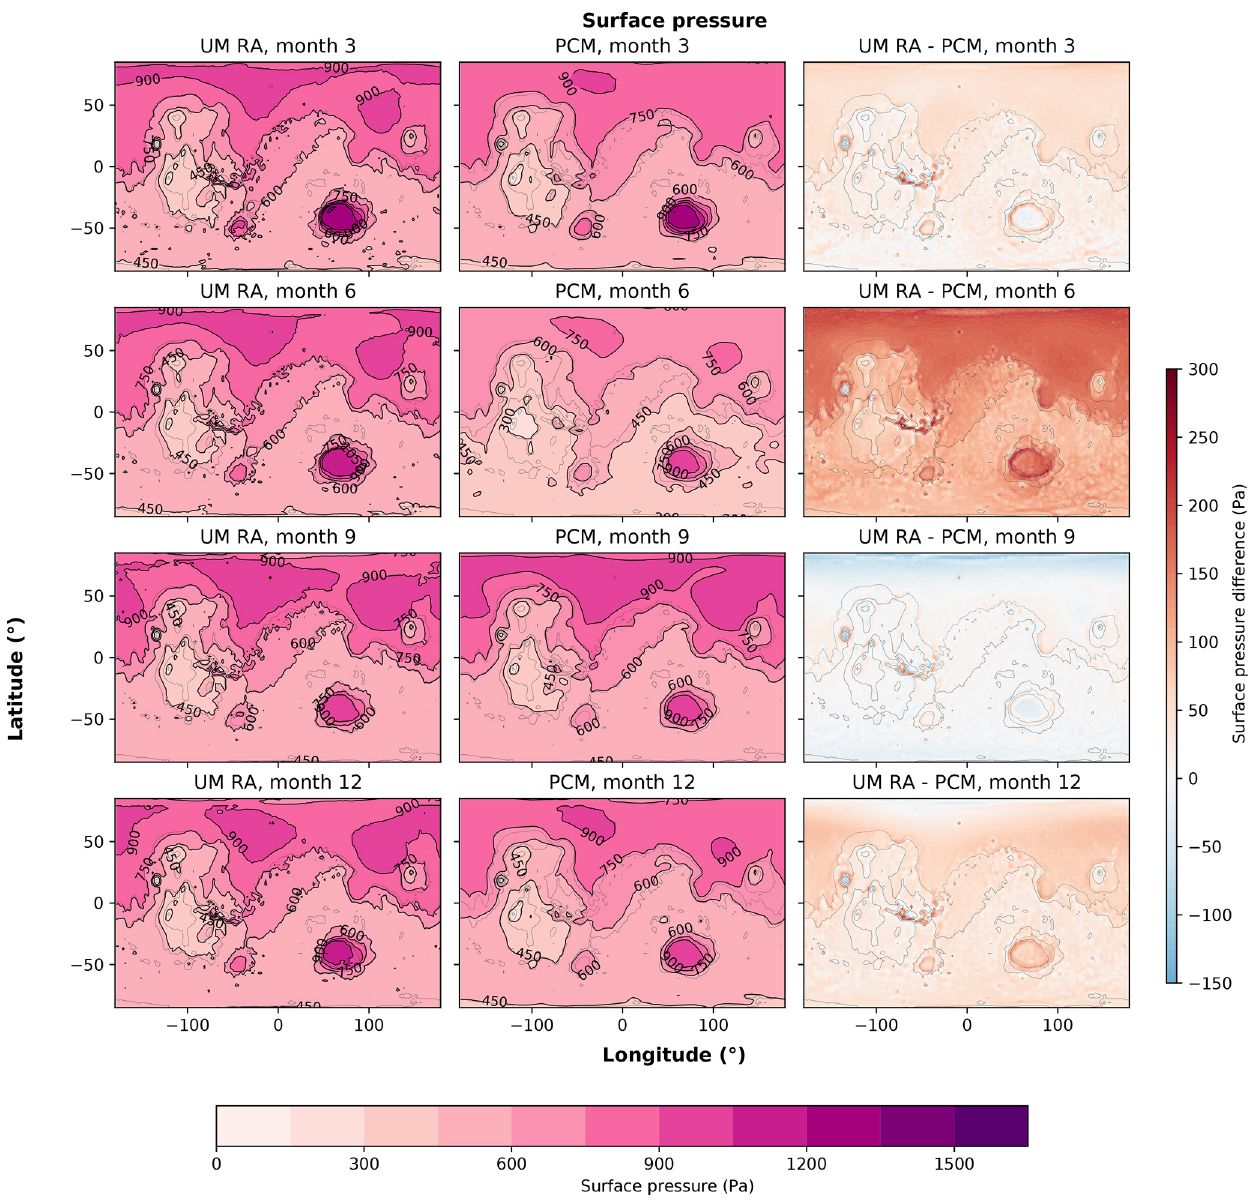
Figure 6. Surface pressure (Pa) across four seasons within the Martian year. For each month, the time average is taken of all sols within that month. The RA dust scenario is shown on the left, the PCM output is in the centre and the differences between the RA and PCM outputs are on the right. Colour scales in the left-hand and centre plots are matched across all months and between models with contour intervals of 150Pa. The colour scales in the difference plots are also matched across all months. Contours are not shown due to the sharp changes in pressure around craters creating steep differences within a small